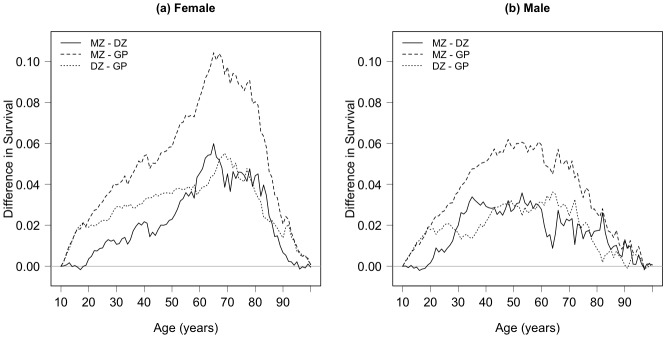
Pairwise differences in cumulative survival proportion among Danish twins and the general population.Difference in cumulative survival proportion (lx column of the life table) between MZ and like-sex DZ twins born in Denmark 1870–1900 (solid line), MZ twins and the Danish general population cohort 1870–1900 (dashed line), and DZ twins and the Danish general population cohort 1870–1900 (dotted line). GP: general population, DZ: dizygotic, MZ: monozygotic.